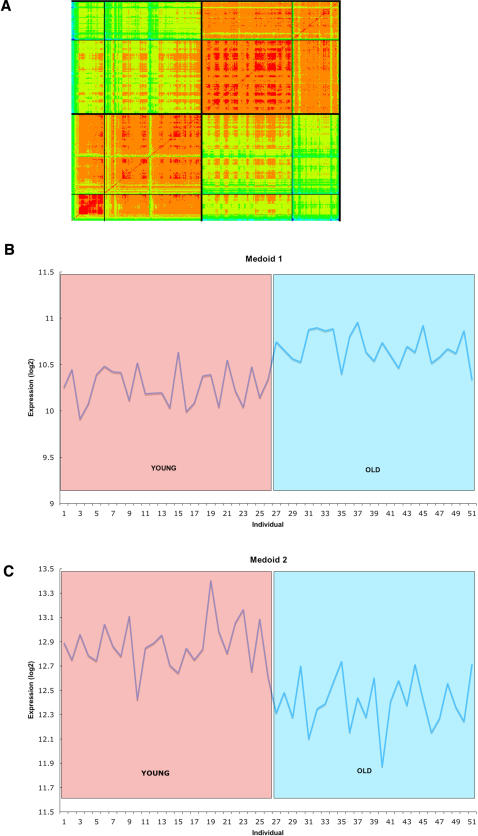
Differential Gene expression in physiologically normal individuals with age.Ordered distance matrix using the HOPACH algorithm[53] of significantly differentially expressed genes in young versus old skeletal muscle (FWER<0.05). Bold lines surround the first level of clustering, with the less bold lines indicating secondary clustering. Green to blue to purple is close to far. B) Medoid gene expression profile of a gene illustrating the expression behavior of cluster 1. C) Medoid gene expression of a gene illustrating the expression behavior of cluster 2.